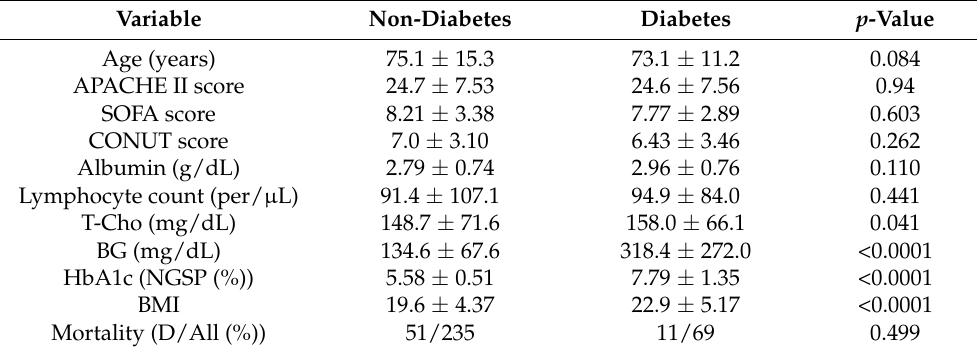
Figure 4. Comparison of CONUT scores in the three glycemic categories. Abbreviations: Hypo-G, hypoglycemia group (blood glucose level < 80 mg/dL); Hyper-G, hyperglycemia group (blood glucose level ≥ 200 mg/dL); Inter-G, intermediate glycemia group (blood glucose level = 80 – 119 mg/dL). The comparison of baseline characteristics between patients with and without diabetes indicates chronic glycemic status, as shown in Table 4. There were no statistically significant differences in their outcomes and general nutritional statuses, such as BMI and CONUT score, except for the total cholesterol level, which is one of the components of the CONUT score. BGL and HbA1c values in the diabetes group were significantly higher than in the non-diabetes group. The ratio of glycemic abnormality groups, such as Hyper-G and Hypo-G, was shown in the diabetes group to have significant differences. Total cholesterol level in the Hyper-G group was higher than that of the non-Hyper G group (169.6 ± 62.6 vs. 144.1 ± 72.0, respectively; data not shown). Table 4. Comparison of baseline characteristics according to the presence of diabetes.